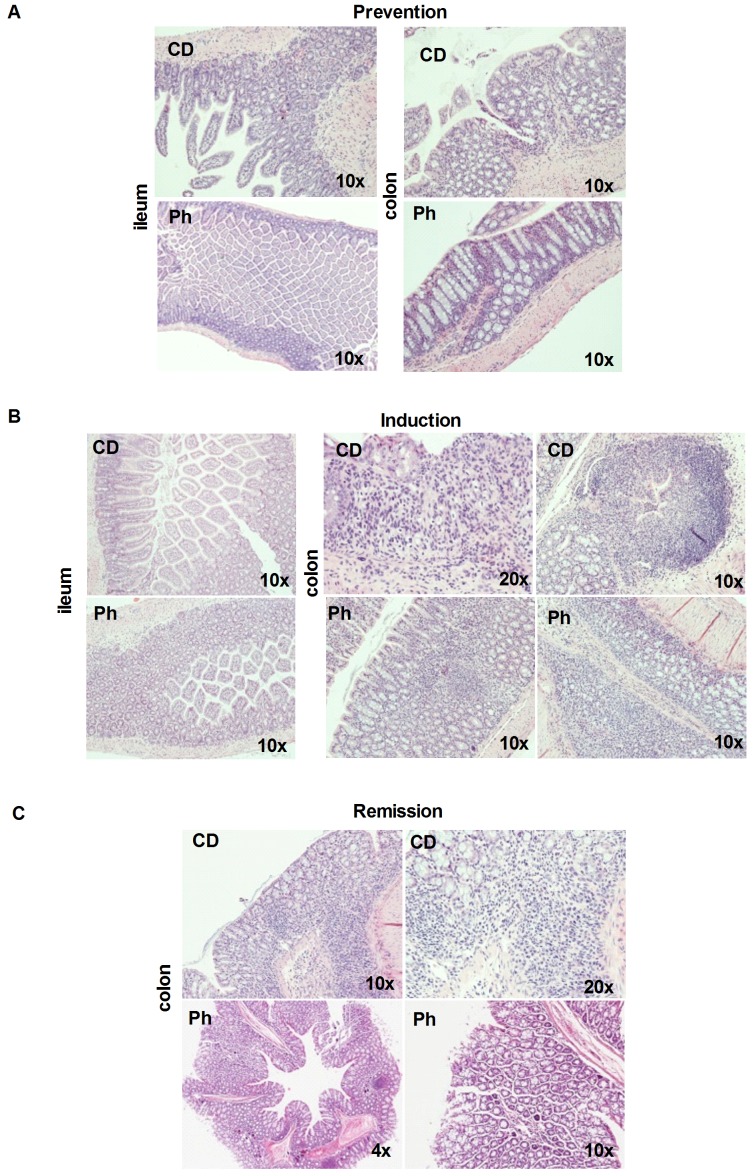
Assessment of acute colitis and evaluation of the response to Ph. Histology.Prevention: normal ileum (Left) and colon (Right) in CD and Ph mice. (H&E,4x). Induction: colonic sections from ileum and colon from CD and Ph. The ileum is normal in both groups. Colon. Upper panel. Left: mucosal ulceration with linfoplasmacytic and neutrophils infiltrate extending to the entire mucosa (H&E, 20 x). Right: cryptic abscess (H&E, 10 x). Lower panel: colonic sections from Ph mice at the end of the induction period. Left: The mucosa and sub-mucosa show a moderate inflammatory infiltrate with lymphocytes and neutrophils (H&E, 10 x). Right: follicular inflammation. (H&E, 10 x). Remission. Upper panel: colonic mucosa specimens. Left: inflammatory infiltrate (H&E, 4x). Right: inflammatory infiltrate with lymphocytes and neutrophils (H&E, 20 x). Lower panel: colonic mucosa specimens. Left: minimal focal lymphocytes infiltration (H&E, 4x). The same at higher magnification (H&E, 10x).